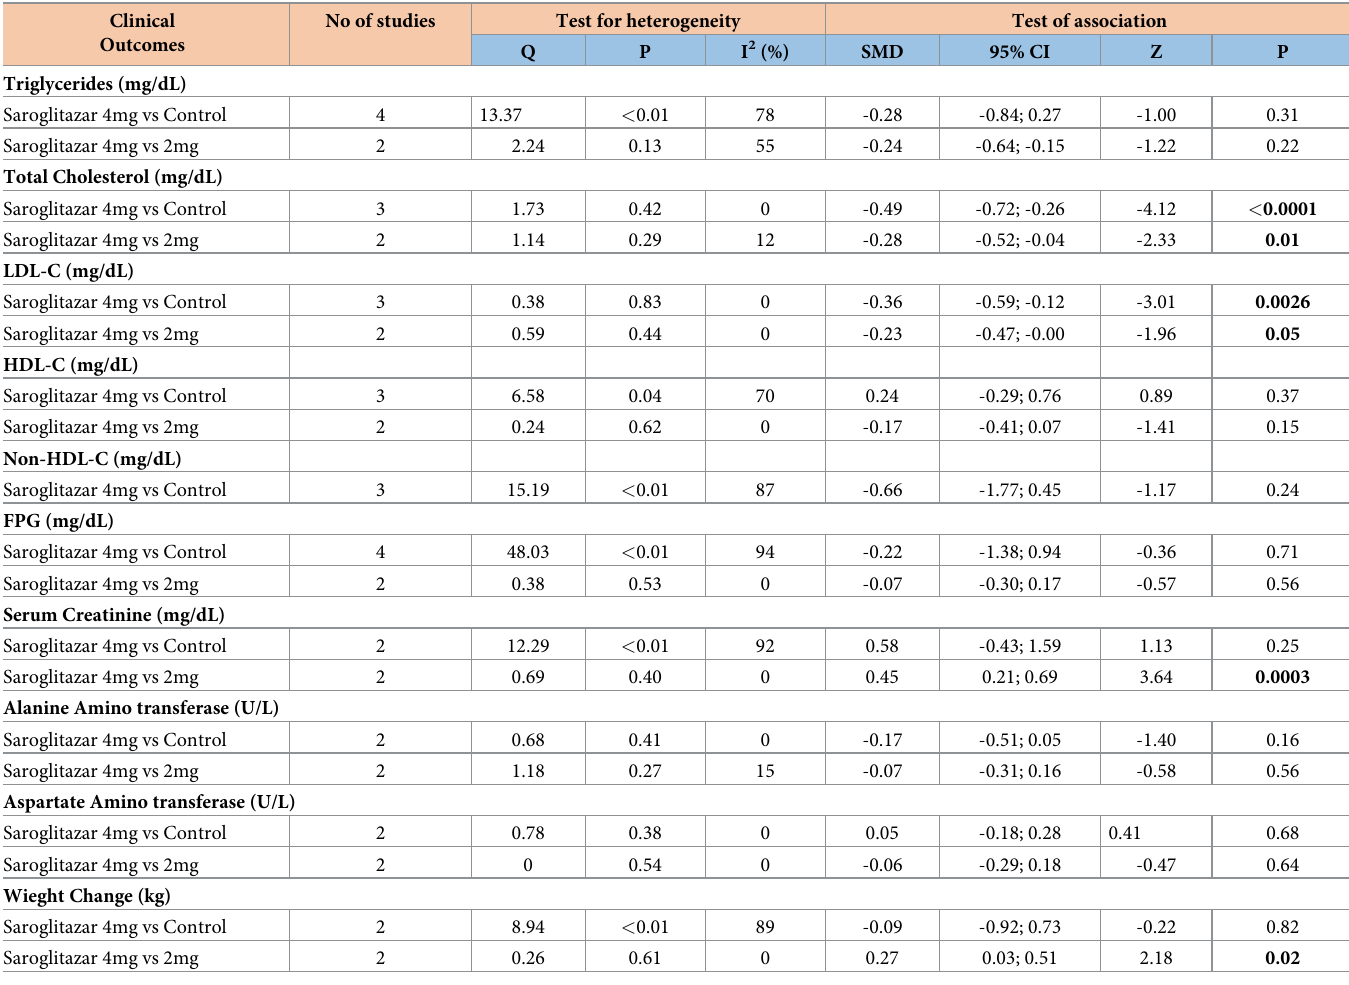
Table 3. Mean absolute change results of all clinical outcomes measured in diabetes related dyslipidemia. Clinical No of studies Test for heterogeneity Test of Outcomes